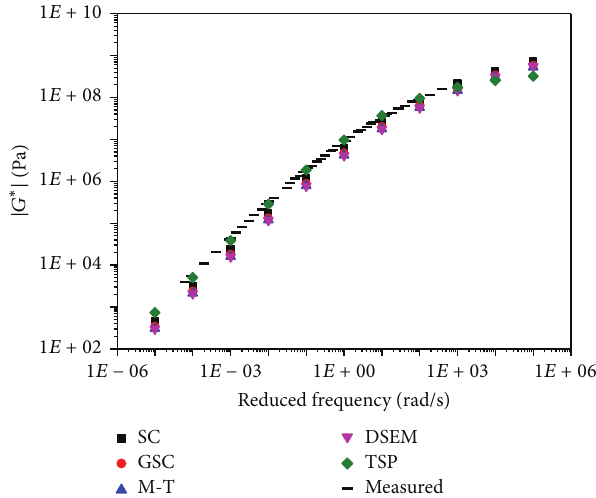
Figure 4: Predicted and measured dynamic shear modulus of mastic.